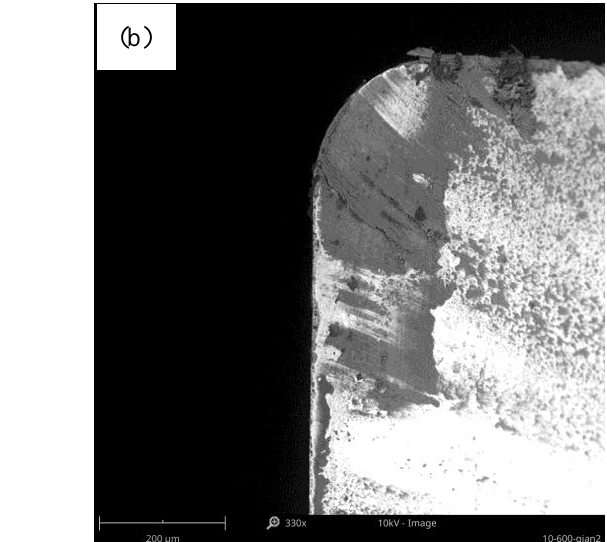
Figure 14. The wear morphology of rake face at 600 m/min when the milling length reached ( a ) 7.5 m; ( b ) 10 m.